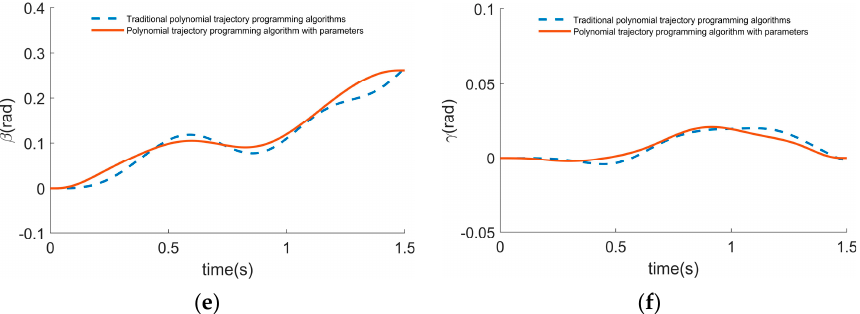
Figure 6. Trajectory poses solved under two planning algorithms. ( a ) Comparison of x -direction dis- placement; ( b ) Comparison of y -direction displacement; ( c ) Comparison of z -direction displacement; ( d ) Comparison of α angular; ( e ) Comparison of β angular; ( f ) Comparison of γ angular.